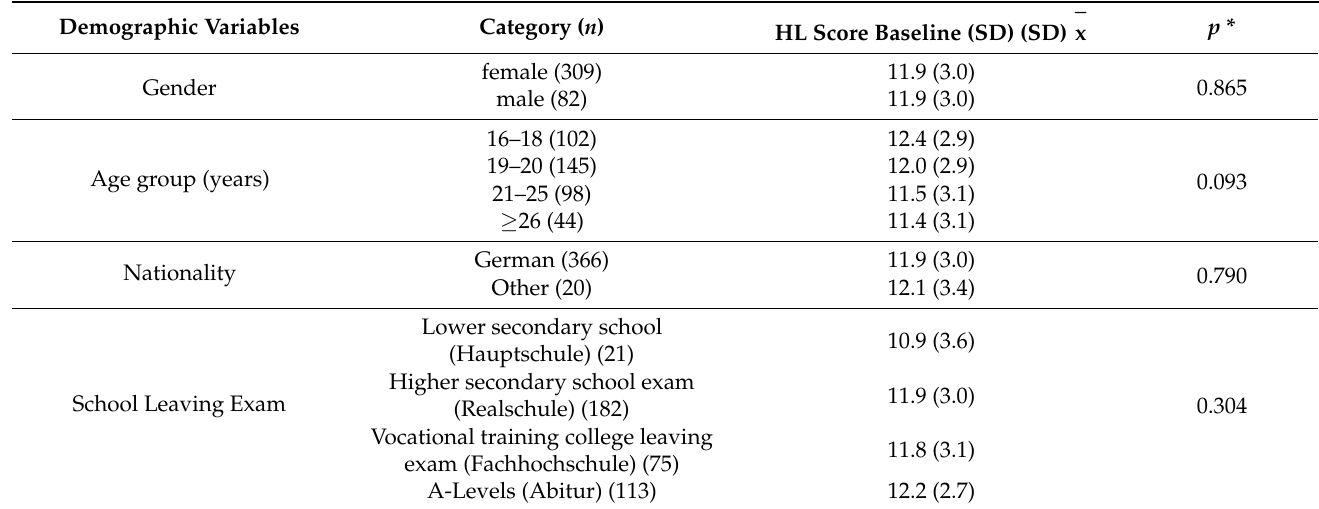
Table 2. Health literacy (HL) for different demographic variables.